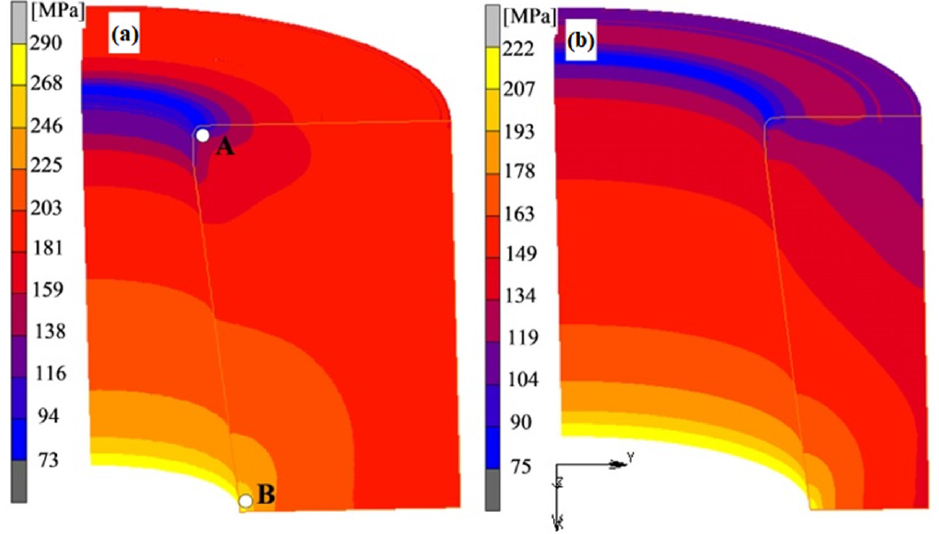
Figure 6. Distribution of Huber–Mises stress in the die during extrusion: ( a ) R = 11, ( b ) R = 3 (A and B—measuring points of stress in all models).